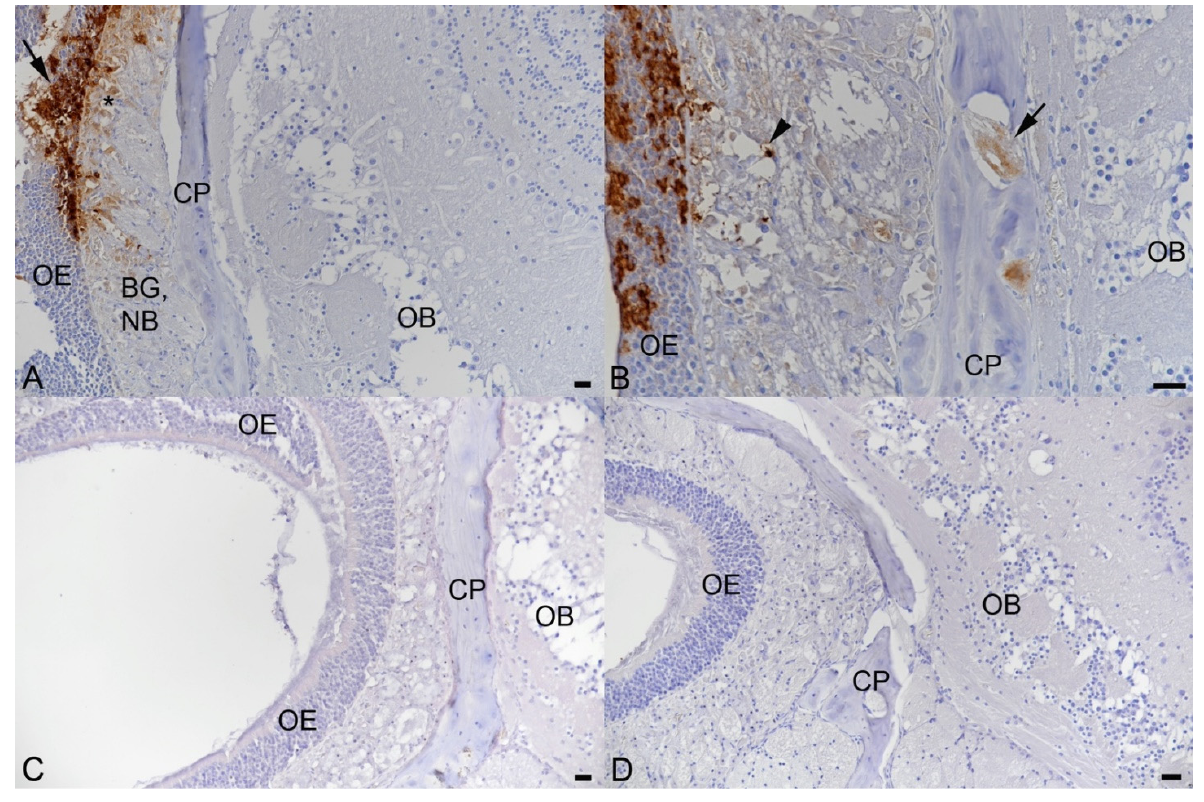
Figure 3. SARS-CoV-2 NP expression in the nose of BALB-C mice after intranasal infection with 2 × 10 5 PFU of beta variant ( A , B ) and wt SARS-CoV-2 ( C ). Olfactory epithelium (OE), bony cribriform plate (CP) and olfactory bulb (OB), midline longitudinal section, head. ( A ). Female animal infected with beta SARS-CoV-2 and euthanized at 2 dpi. Strong, patchy, viral antigen expression in olfactory epithelial cells (arrow) and a few cells (*) in the underlying layer containing Bowman’s glands (BG) and nerve bundles (NB). There is no evidence of viral antigen expression in the olfactory bulb. ( B ). Male animal infected with beta SARS-CoV-2 and euthanized at 3 dpi. Strong, patchy, viral antigen expression in olfactory epithelial cells (OE) and a few cells (arrowhead) in the underlying layer containing Bowman’s glands and nerve bundles. There is also evidence of viral antigen expression in olfactory nerves (arrow) perforating the bony cribriform plate. ( C ). Female animal infected with wt SARS-CoV-2 and euthanized at 3 dpi. There is no evidence of viral antigen expression. ( D ). Mock-infected male animal euthanized at 2 dpi. Again, there is no evidence of viral antigen expression. Bars = 20 µm. Immunohistochemistry, haematoxylin counterstain.